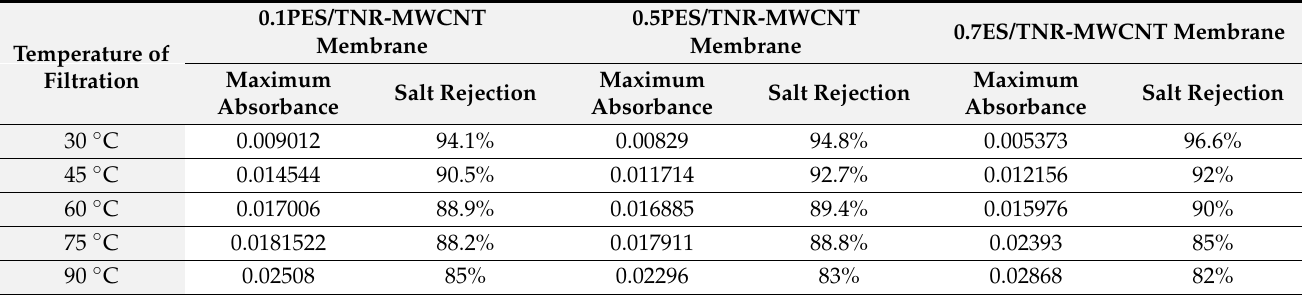
Table 2. Values of the maximum absorbance and filtration efficiency for 100 ppm Sr 2+ aqueous solutions at different temperatures using 0.1, 0.5, and 0.7 PES/TNR-MWCNT membranes.